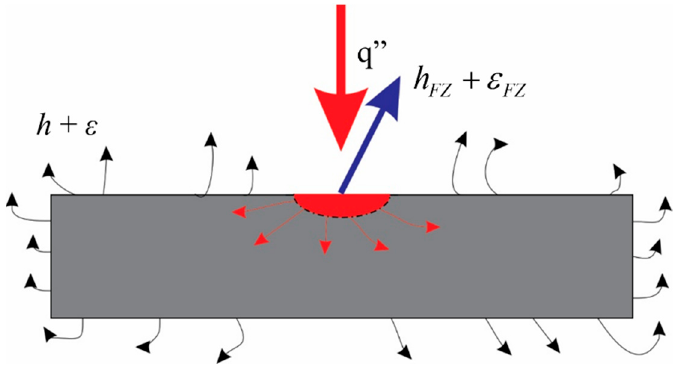
Figure 3. Scheme representation of the numerical performed analysis.